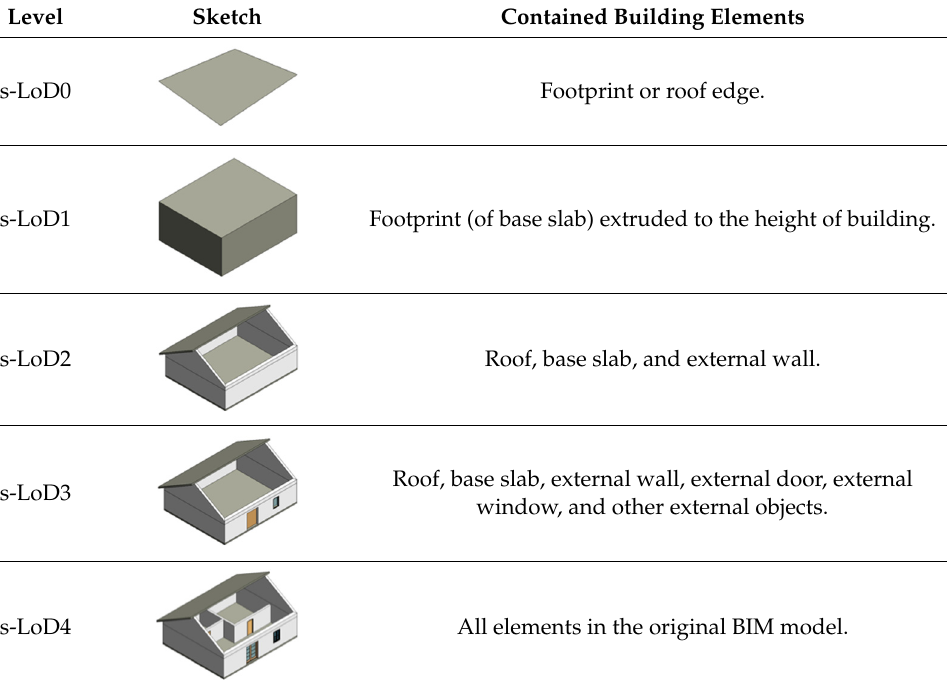
Figure 4. The Unified Modeling Language (UML) diagram of the semantic data model for the solid building model. 3.2.2. Implementing s-LoDs Based on this semantic data model, an overall framework for generating s-LoD1 to s- LoD4 models was developed, as shown in Figure 5. For s-LoD4, all building components can be individually generated. Models of s-LoD1 can be generated using information from the base slab and the building height. Models of s-LoD2 were produced using raw geo- metric information and semantic information from roofs, base slabs and external walls. Lastly, s-LoD3 models were created using information from external doors, external win- dows, roof, base slabs and external walls. While challenges in surface model simplification come from exterior shell extraction and opening removal for generating LoD2 and LoD3 models [16], the unique challenges in solid model simplification and generation mainly come from the following aspects, in- cluding (1) identifying external objects for s-LoD2 and s-LoD3; (2) distinguishing various slabs, which are used for different purposes in construction, such as roofs, floors and base slabs; and (3) generating valid external walls for s-LoD2 and s-LoD3. (1) Identifying external objects For a specific building element, external objects should be identified for s-LoD2 and s-LoD3, and a reliable method for distinguishing external objects is essential to imple- menting s-LoDs. After a thorough investigation into the IFC standard, it can be noted that two methods can be used for this purpose, i.e., using the 𝐼𝑠𝐸𝑥𝑡𝑒𝑟𝑛𝑎𝑙 attribute of building